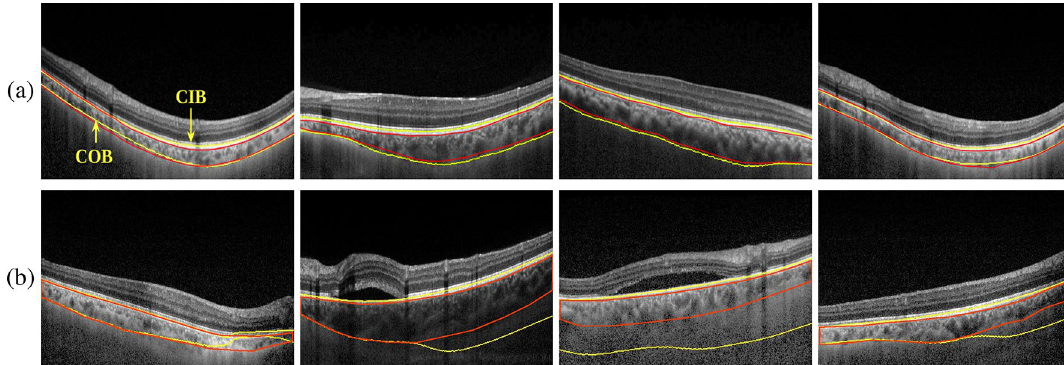
Figure 3. Choroid boundary (CIB & COB) detection on OCT images via both manual(red) and algorithm(yellow) with : ( a ) good quality, and ( b ) bad